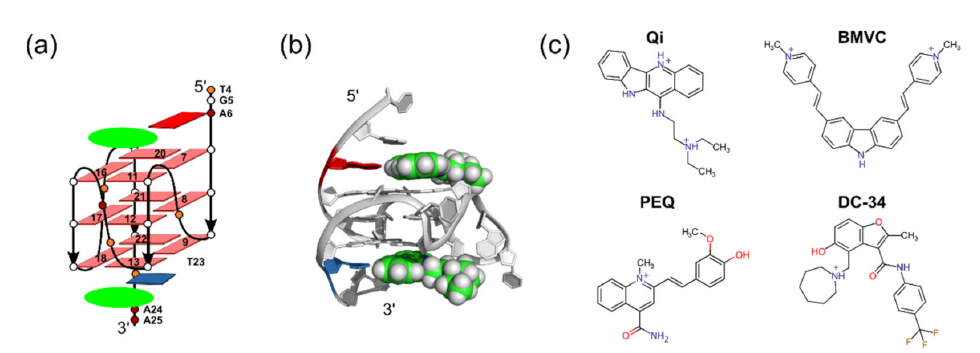
Figure 1. ( a ) Schematic structure of the MycG4 bound by two ligands (green oval) stacking on the external tetrads and recruiting a flanking residue. ( b ) A ribbon representation of the MycG4 in complex with the PEQ ligand bound at the 5 (cid:48) -end and 3 (cid:48) -end (PDB: 2L7V). ( c ) Chemical structures of the four MycG4 ligands studied in this